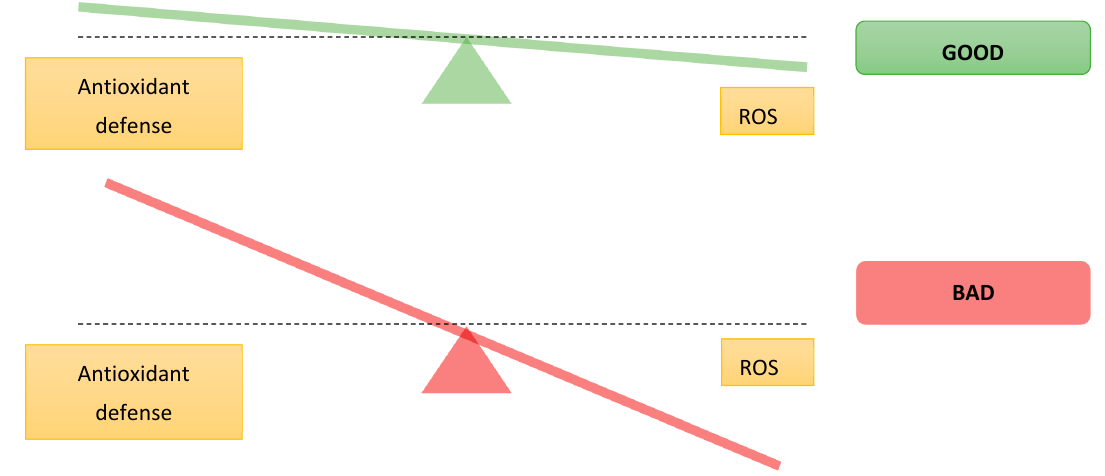
Figure 2. Difference between the normal and the disease state of oxidative stress balance adapted from Poljsak et al. [29].